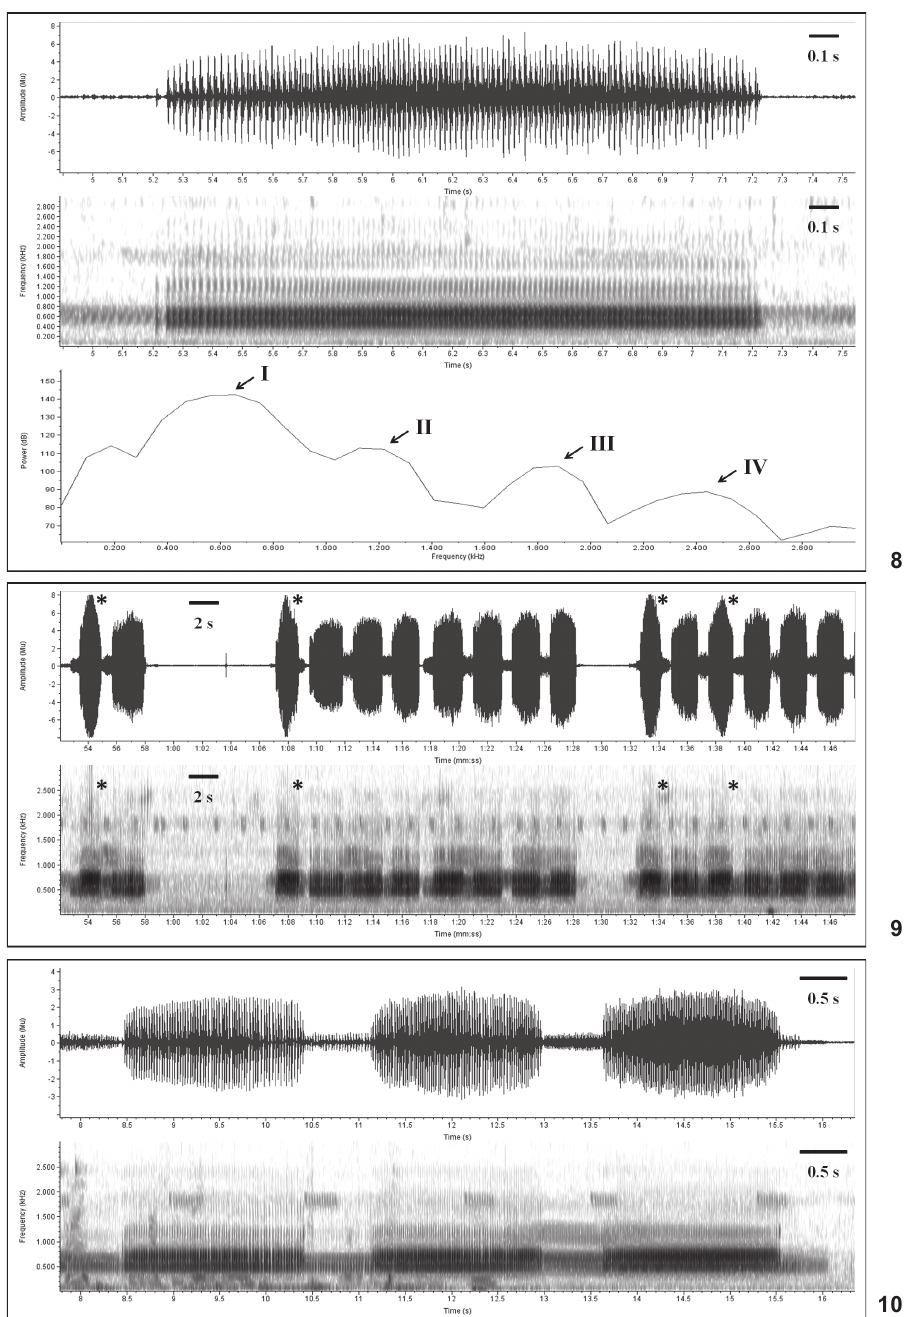
Figures 8-10. Advertisement call of Proceratophrys appendiculata , spectrogram and power spectrum with window function Hann, ampli- tude logarithmic, window size 512 and 256 samples respectively, overlap 99%. (8) Oscillogram (top), spectrogram (middle) and power spectrum (bottom) of one call. Note the first longest period and the first two harmonics with more energy (harmonics indicated by Roman-numbered arrows in power spectrum). (9) Oscillogram (top) and spectrogram (bottom) of sixteen calls with and without promi- nent amplitude peak (see text). The first ones are flagged with asterisk and show higher pulse rates. (10) Oscillogram (top) and spectro- gram (bottom) of three calls without prominent amplitude peak. Note the pulse rate variation, increasing from the first to the last